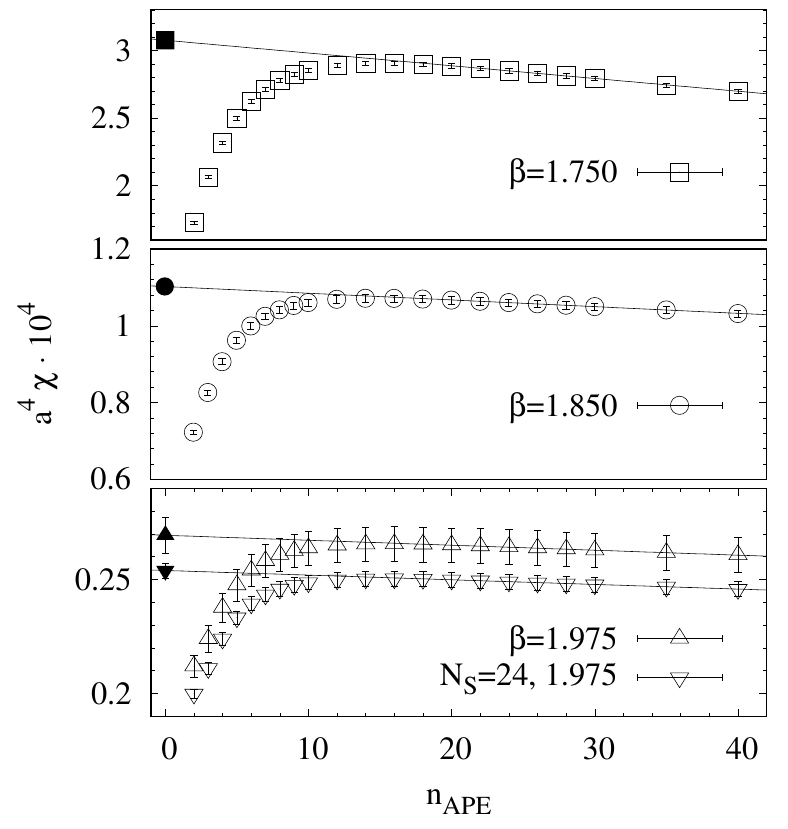
Figure 8 . a 4 χ for the four ensembles as a function of n APE